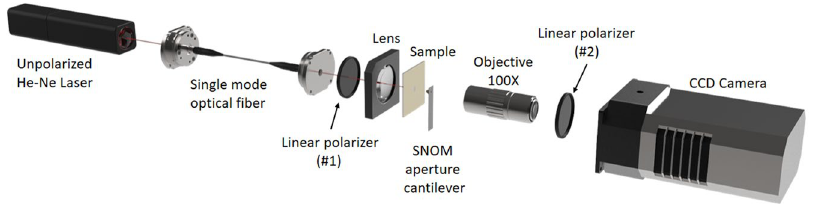
Figure 1. SNOM (Scanning Near-field Optical Microscopy) setup used for near-field characterization of single nanoholes. SNOM measurements are performed in transmission mode with a NT-MDT NTEGRA Spectra microscope using a SNOM aperture cantilever in contact mode. As exciting source, we used an unpolarized He-Ne laser ( λ exc = 632 nm ) coupled to a single mode optical fiber. A linear polarizer (#1) is placed at the end of the optical fiber and the polarized beam is focused onto the sample surface. Resulting radiation is collected